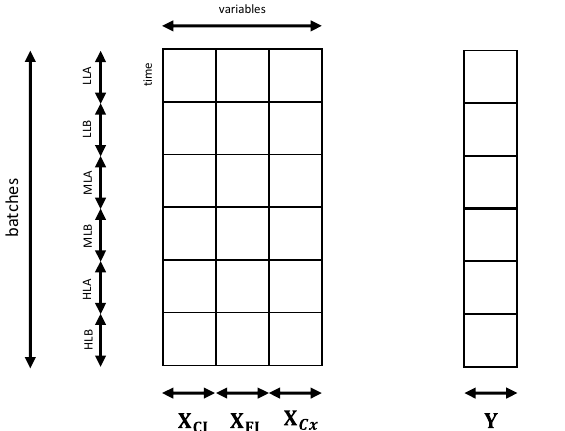
Figure 3. Matrices used to build the PLS models to estimate Chl a content. The predictor matrix 𝐗 was built concatenating 𝐗 𝐂𝐈 , 𝐗 𝐅𝐈 and the vector containing biomass concentration 𝐗 𝐂𝐱 depending on the model. The response matrix 𝐘 [144 × 1] consisted of the Chl a content.